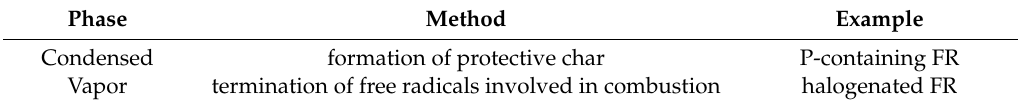
Table 1. Mechanisms of flame retardancy based on phase and example of each.